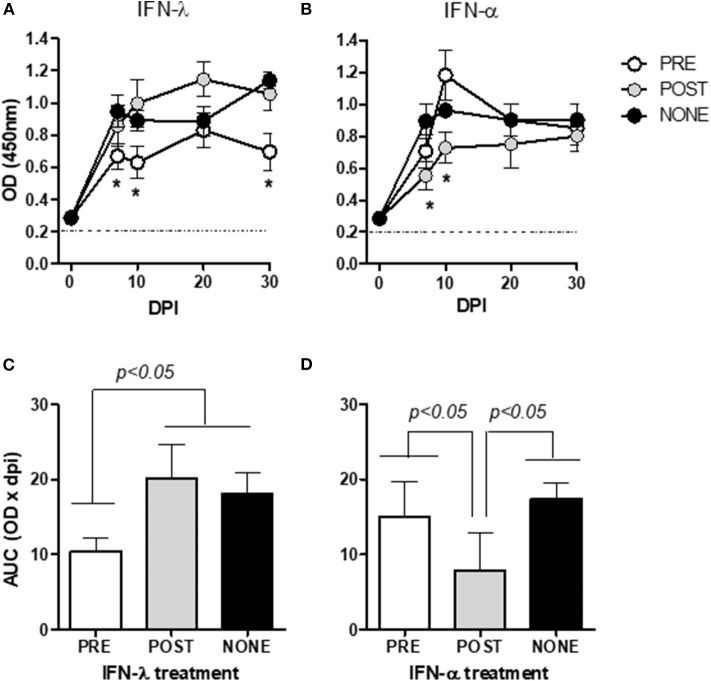
Effect of IFN prophylaxis or treatment in viremia. In the figures, the kinetics of viral replication, are expressed as mean OD450 ± SD of triplicate values. Mice were inoculated with either IFN-λ (A) or IFN-α (B) before (PRE, white circles) or after (POST, gray circles) infection, or infected but left untreated (NONE, black circles). The figures of (C) (IFN-λ) and (D) (IFN-α) are plots of the areas under the respective curves from (A,B) (mean ± SD) for the three inoculation protocols (PRE, POST, and NONE). The corresponding values for the noninfected mice (mock-infected groups) were below the detection levels of the assay and are thus not included in the figures. The asterisks (*) in (A,B) denote values significantly lower than those measured in the NONE group (p < 0.05). The dotted horizontal line in figures (A,B) depict the cut-off value. DPI, days post-infection.